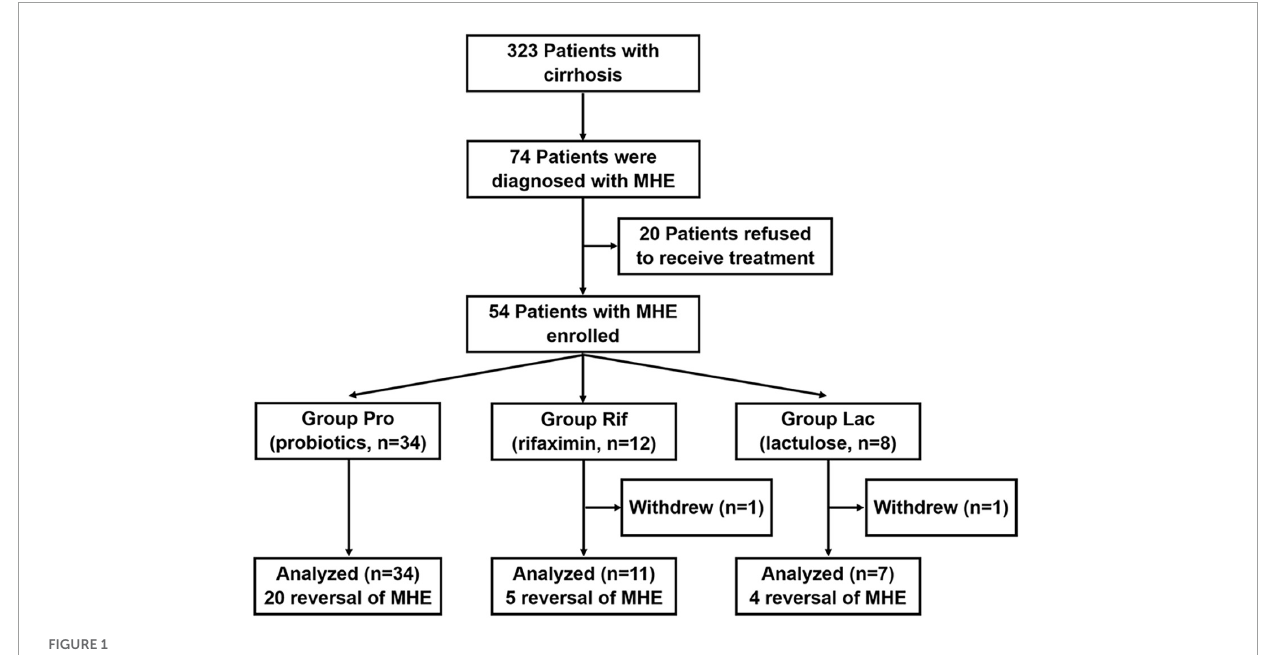
FIGURE1 Flow of patients of treatment for